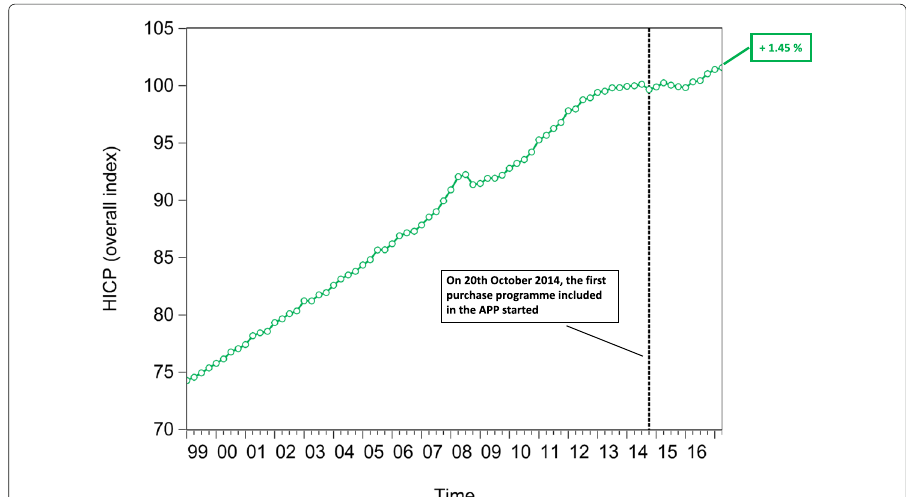
Fig. 19 Euro area HICP; 1999Q1-2017Q2. Time series of the Harmonised Consumer Price Index (HICP), over the reference period 1999Q1-2017Q2. The vertical line corresponds to the beginning of the first purchase programme (3rd Covered Bond Purchase Programme, CBPP3) included in the APP, started in 2014Q4, while the percentage on the right-hand side of the graph corresponds to our estimate of the growth rate of euro area HICP, since the initiation of QE. Data source: (European Central Bank